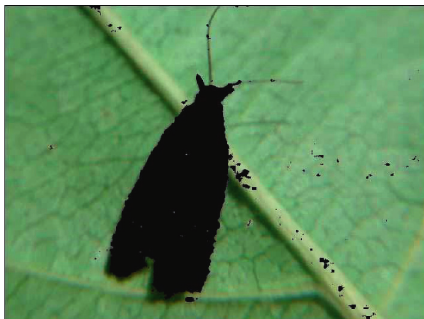
Figure 5: The original image of a leaf-curler adult on a sample of leaf-curler adult (from https://www.docin.com/p-750790572.html).